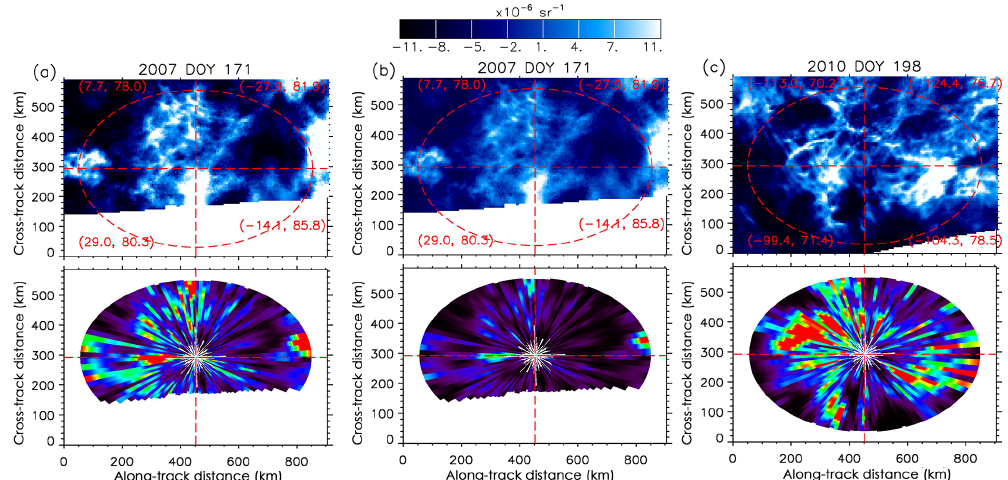
√ 2.778 (see text in Sect. 5.3)